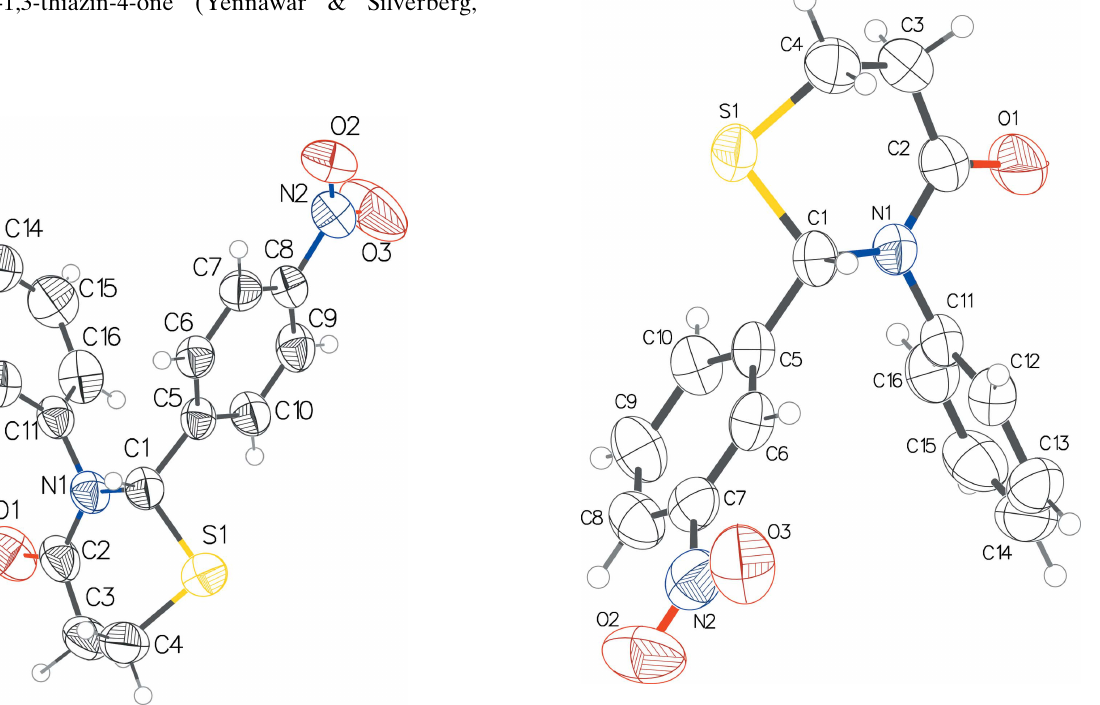
Figure 1 The molecular structure of 1 , with displacement ellipsoids drawn at the 50% probability